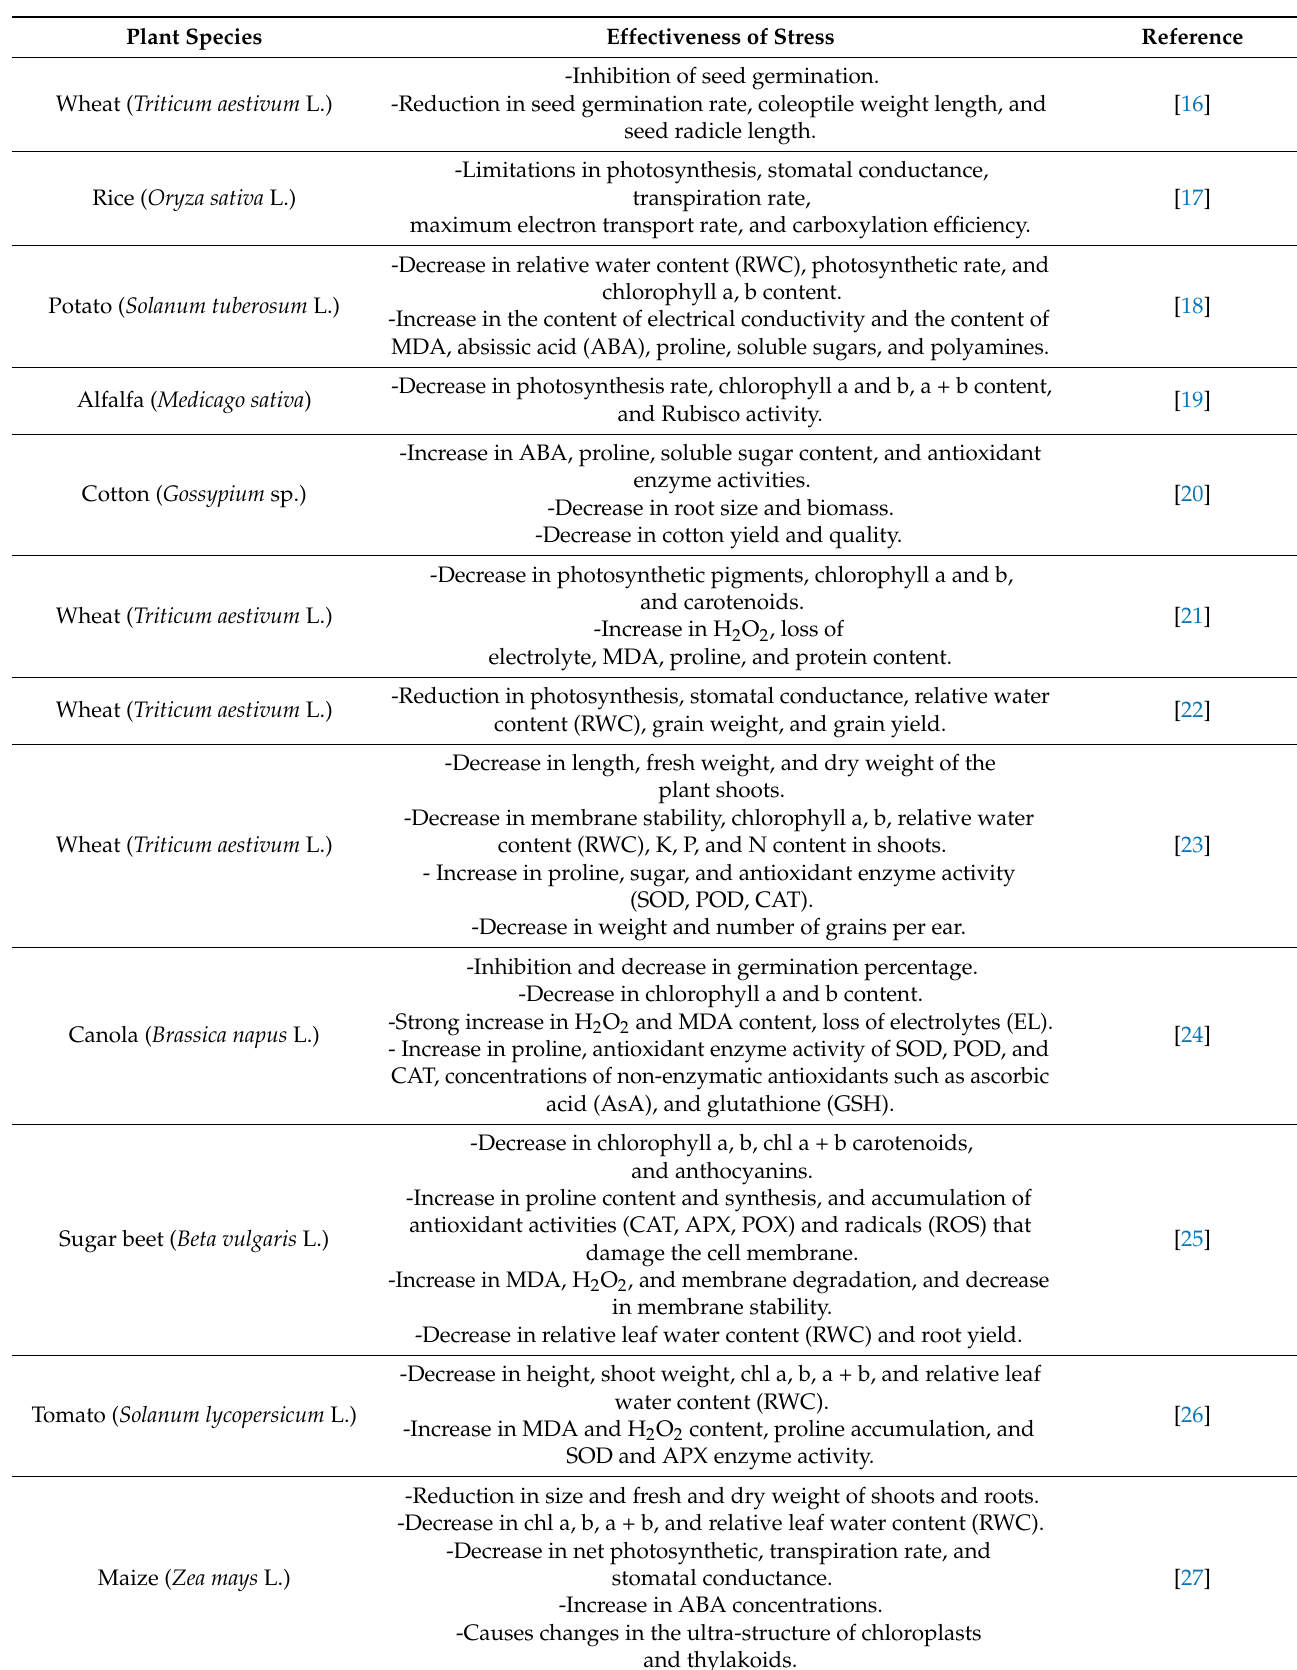
Table 1. Impact of water stress on plant growth and